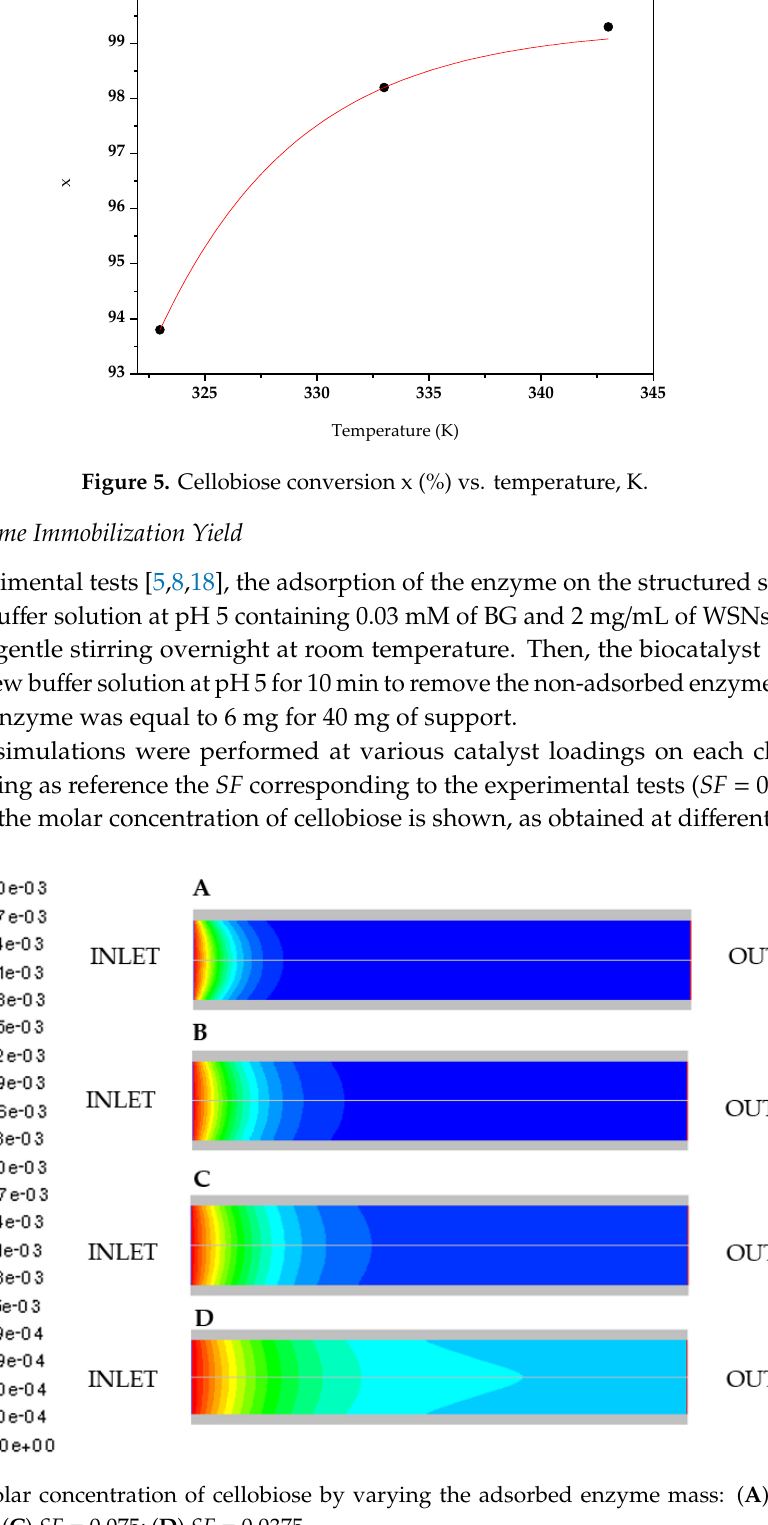
Figure 7. Cellobiose conversion x (%) over SF . The continuous lines originate from the nonlinear fit of the numerical results, reported by the dots. A Michaelis–Menten curve has been considered the most appropriate to describe both cellobiose conversion and SF . When the SF factor is 0.075, the conversion reaches a plateau, corresponding to the complete conversion of cellobiose. Therefore, an increase in the amount of the adsorbed biocatalyst is useless to improve the final glucose concentration and would only cause extra costs. Consequently, we proved that a very low amount of immobilized enzyme can maximize the glucose production.